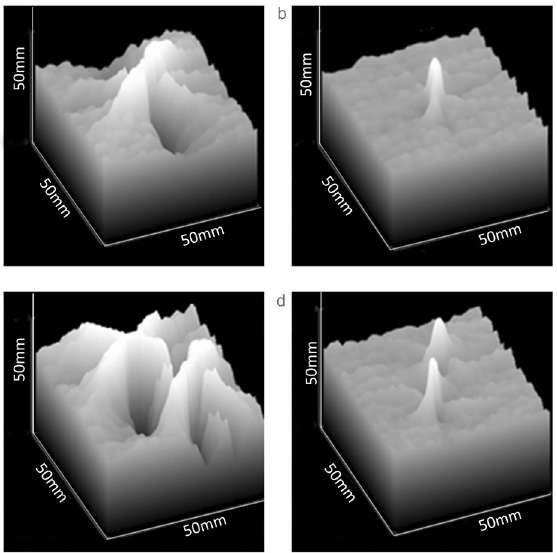
Figure 4. Area gray-scale “terrain” of a 50 × 50 mm square centered on ( a ) Single gold seed, ( b ) Single polymer seed, ( c ) Two adjacent gold seeds, and ( d ) Two adjacent polymer